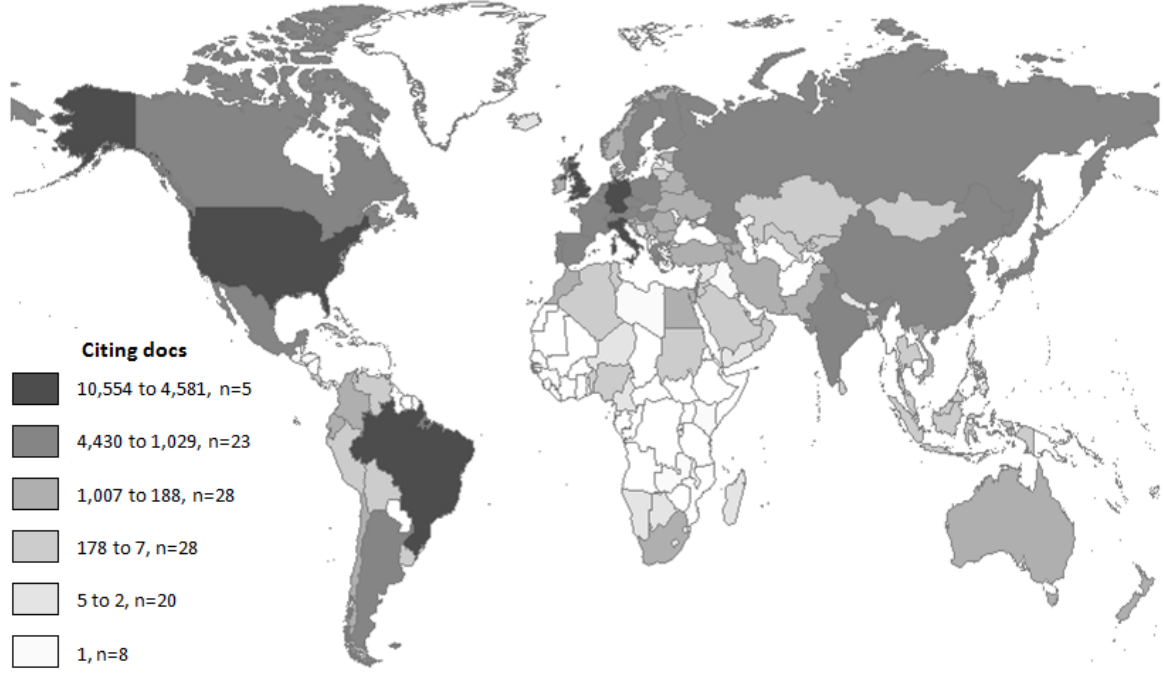
Figure 3 - Geographical distribution of citing documents (all types) for Brazilian HEP,